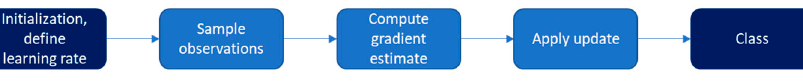
Figure 7. Indicative example of SGD steps.